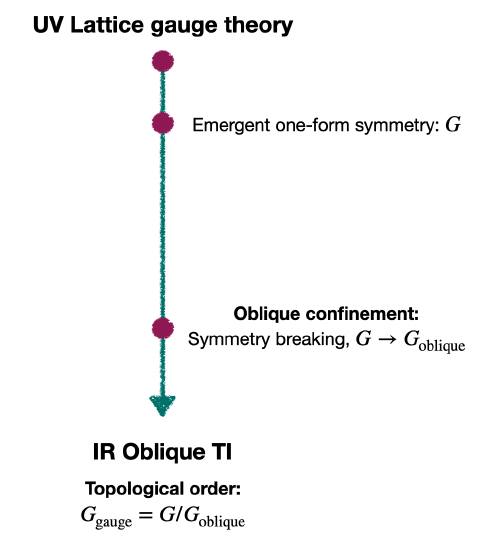
Figure 1: Emergence of the oblique TI phase from a UV lattice gauge theory. When a dyon condenses, the emergent one-form symmetry, G , is broken to a non-trivial ⊂ G . The resulting topological order is that of a (zero-form) gauge subgroup, G oblique = G / G theory with gauge group, G , but now equipped with the residual gauge oblique global symmetry, G oblique